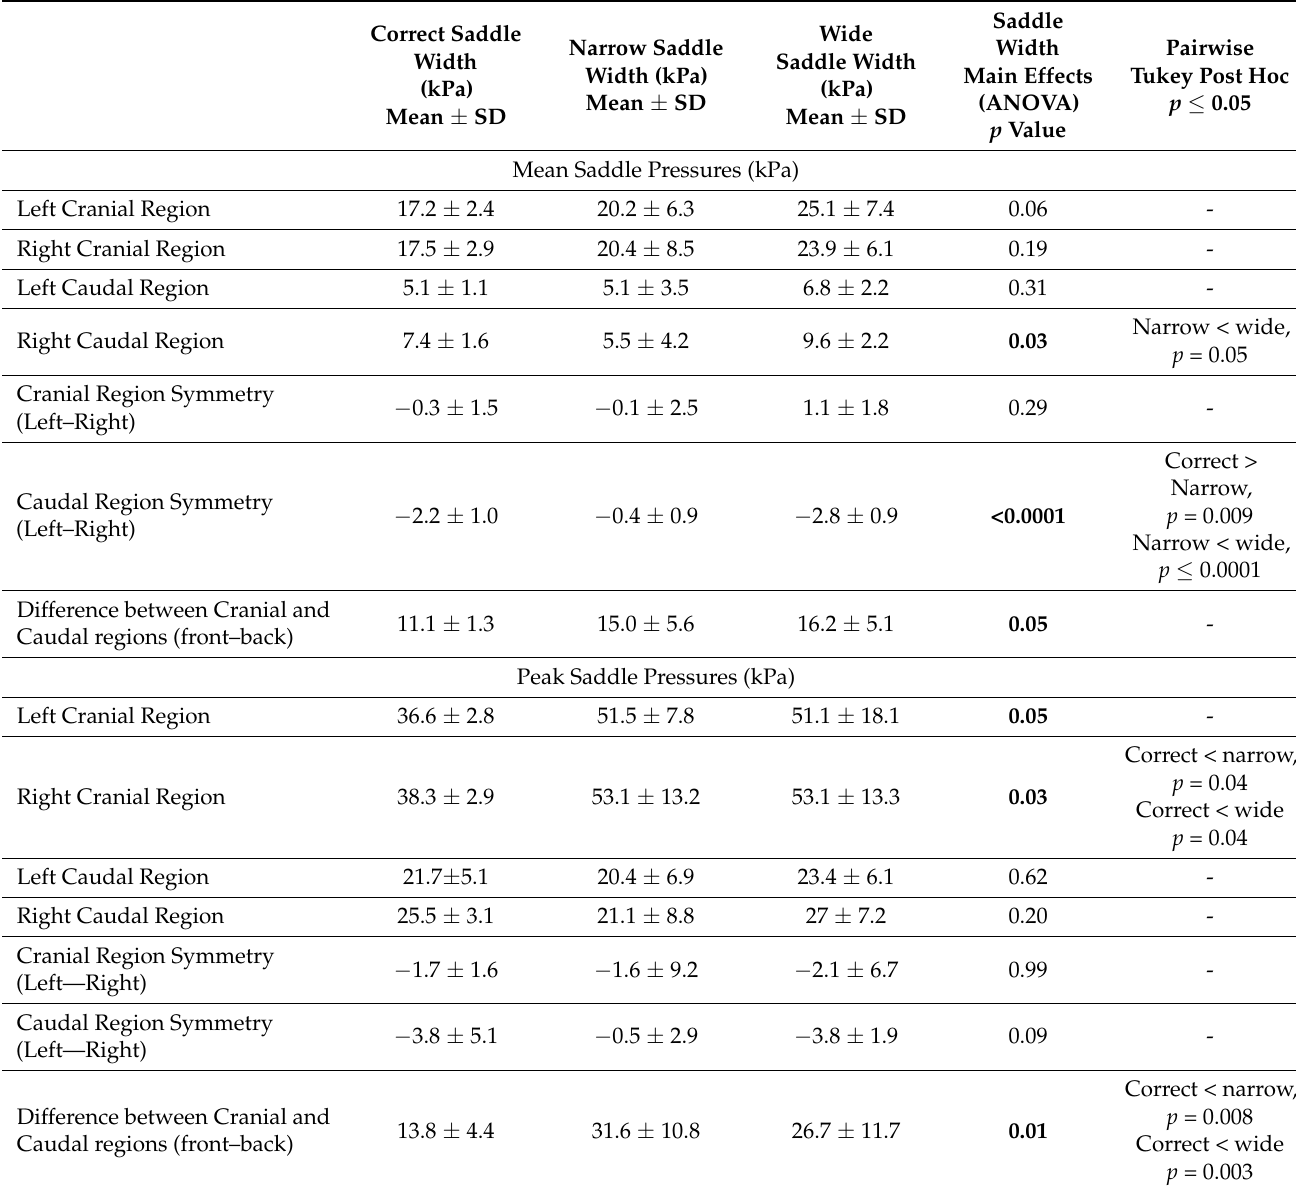
Table 3. Mean and peak saddle pressures (kPa) during a standardised exercise test.